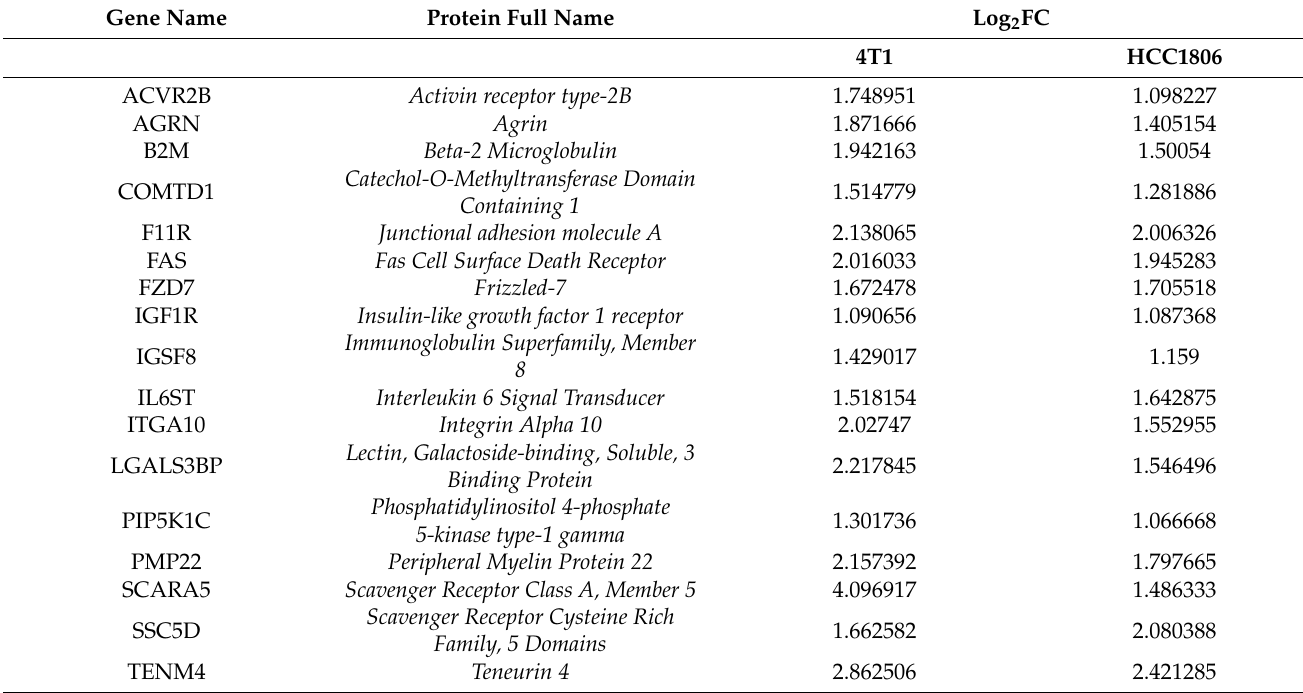
Table 1. Up-regulated transcripts encoding for transmembrane